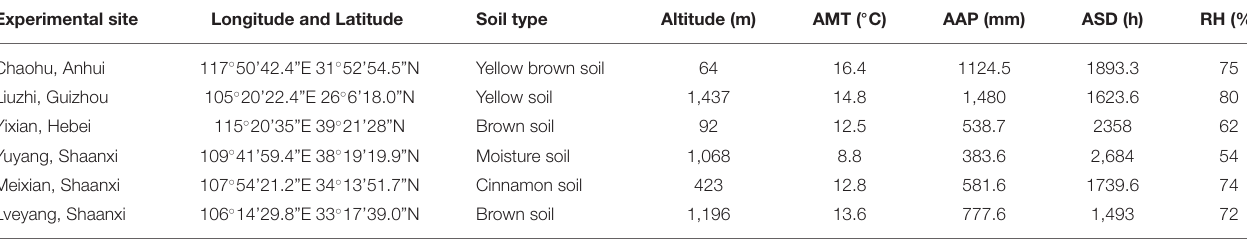
TABLE 2 | The main environmental factors and related data of six experimental sites throughout China. Experimental